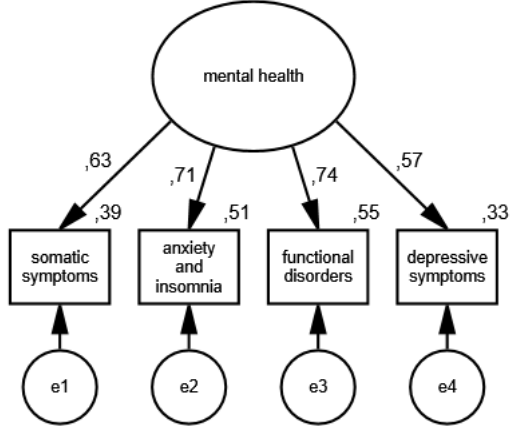
Figure 4. Standardized effects of the mental health disorder measurement model in the group of men . The following measures were obtained during the verification of the model: CMIN/DF = 1.75; GFI = 0.99; AGFI = 0.99; NFI = 0.99; RFI = 0.95; IFI = 0.99; TLI = 0.99; CFI = 0.99; RMSEA = 0.001(0.001; 0.05); PCLOSE = 0.92; N HOELTER(1116; 1442), which con- firm that it is correctly fitted to the data, and the standardized values of factor loadings and the percentages of variances explained in the group of women and men allow for recognizing the constructed model of mental health disorders measurement as accepta- ble. In the third measurement model, the presence of cognitive disorders is an unob- servable variable, and its partial indicators are perceptual work, perception deficits and attention deficits. The results of the verification of the constructed model for measuring cognitive disorders in the group of women are shown in Figure 5, and Figure 6 illustrates the measurement model of cognitive disorders in the group of men.